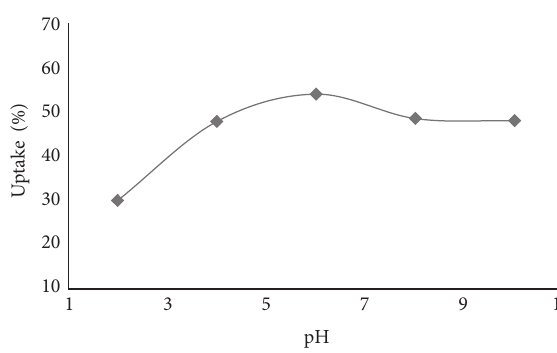
Figure 1: Variation of uptake percentage with pH for cesium sorption on kaolin. Operating conditions: 50 mL solution, [Cs + ] = 25 mg/L, 250 mg kaolin, and shaking time = 40min.